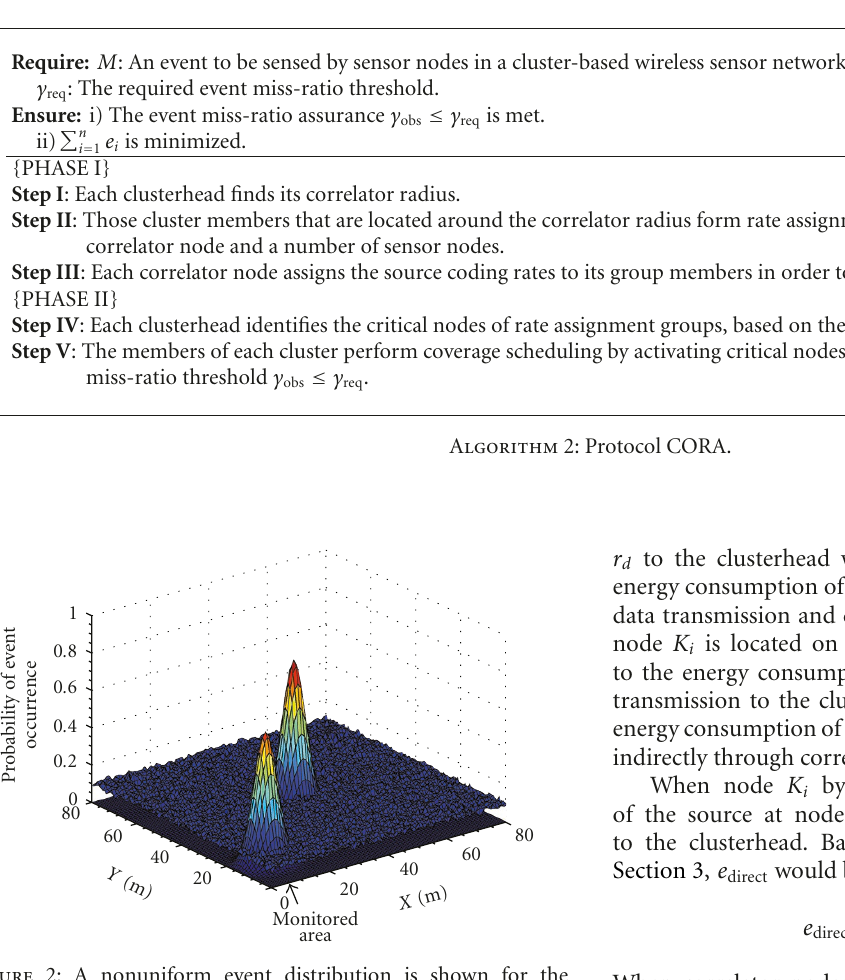
Figure 2: A nonuniform event distribution is shown for the monitored area illustrated in black color. A nonzero probability of event occurrence at any point is depicted in blue